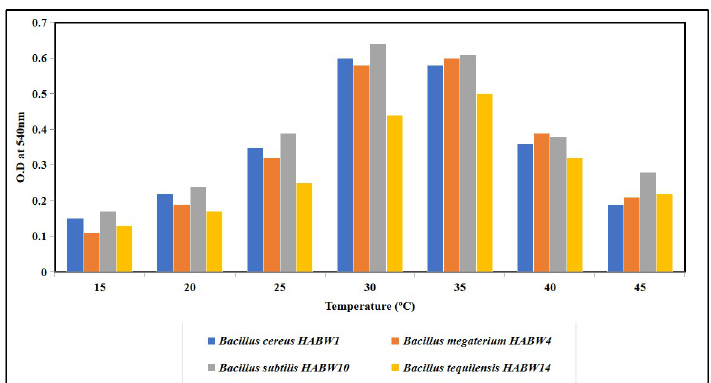
Fig 14. Growth of bacterial isolates at different pH of the media.